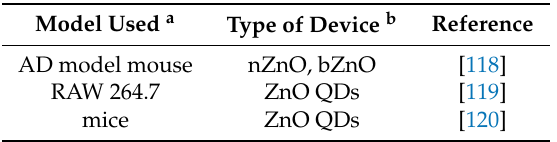
Table 5. ZnO nanoplatforms with anti-inflammatory